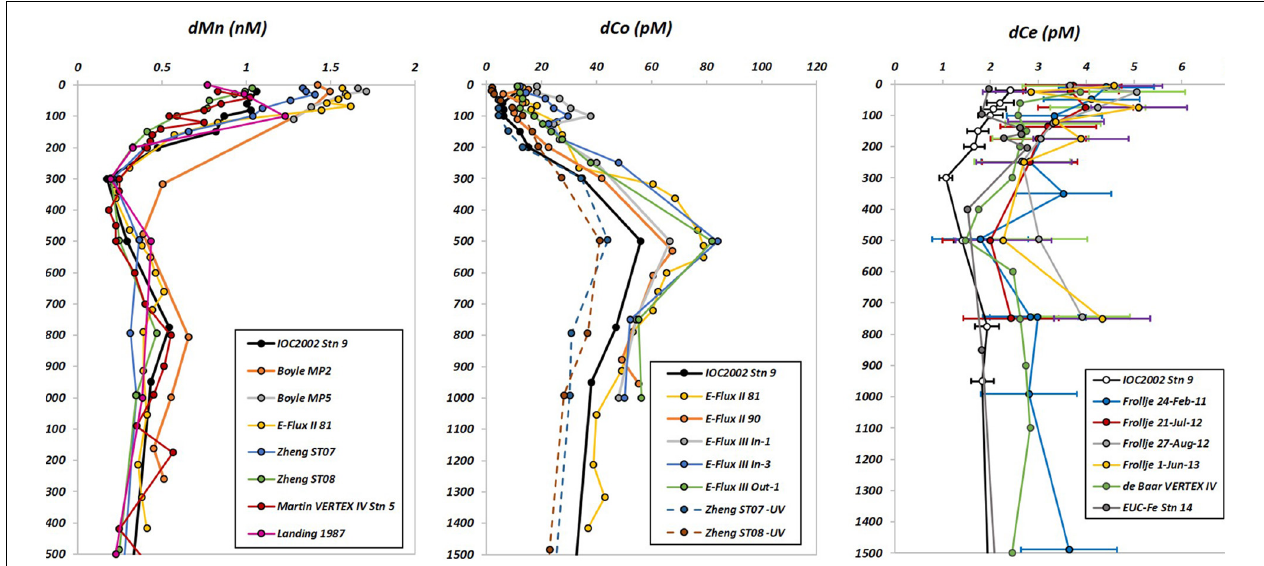
FIGURE 2 | Comparison of vertical profiles of dissolved Mn (left) , Co (center) , and Ce (right) . Error bars ( ± 1 σ ) are shown for Ce. dMn - IOC2002 Stn 9 = this study, Boyle MP2 = station ALOHA, 26 April 2001 (Boyle et al., 2005), Boyle MP5 = station ALOHA, 1 July 2002 (Boyle et al., 2005), E-Flux II 81 = 20.27 ◦ N, 156.94 ◦ W (Noble et al., 2008), Zheng ST07 = 20.001 ◦ N, 160.002 ◦ W (Zheng et al., 2019), Zheng ST08 = 26.33 ◦ N, 160.002 ◦ W (Zheng et al., 2019), Martin VERTEX IV Stn 5 = 28.0 ◦ N, 155.0 ◦ W (Martin et al., 1985), Landing 1987 = 14.7 ◦ N, 160 ◦ W (Landing and Bruland, 1987). dCo - IOC2002 Stn 9 = this study, E-Flux II 81 = 20.27 ◦ N, 156.94 ◦ W (Noble et al., 2008), E-Flux II 90 = 20.50 ◦ N, 157.50 ◦ W (Noble et al., 2008), E-Flux III In-1 = 19.36 ◦ N, 157.08 ◦ W (Noble et al., 2008), E-Flux In-3 = 19.12 ◦ N, 157.03 ◦ W (Noble et al., 2008), E-Flux III Out-1 = 20.62 ◦ N, 157.59 ◦ W (Noble et al., 2008), Zheng ST07 -UV = 20.001 ◦ N, 160.002 ◦ W, without UV oxidation (Zheng et al., 2019), Zheng ST08 -UV = 26.33 ◦ N, 160.002 ◦ W, without UV oxidation (Zheng et al., 2019). dCe - IOC2002 Stn 9 = this study, Frollje 24-February-11 = station ALOHA (Fröllje et al., 2016), Frollje 21-July-12 = station ALOHA (Fröllje et al., 2016), Frollje 27-Aug-12 =